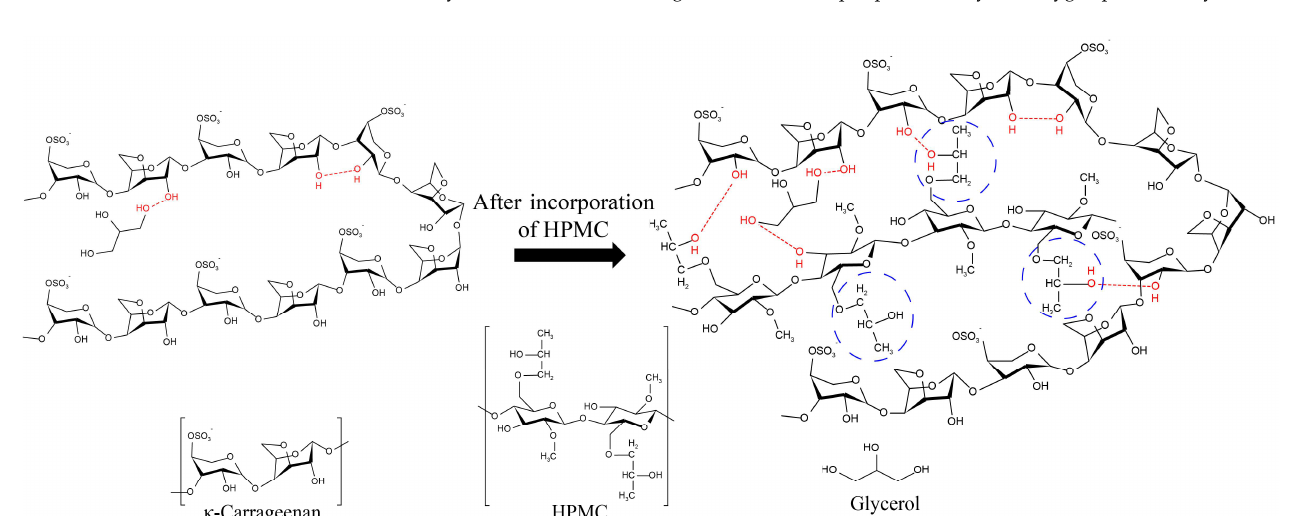
Table 1. Thickness, MC, WS, WCA, WVP and OP of κCHM films.